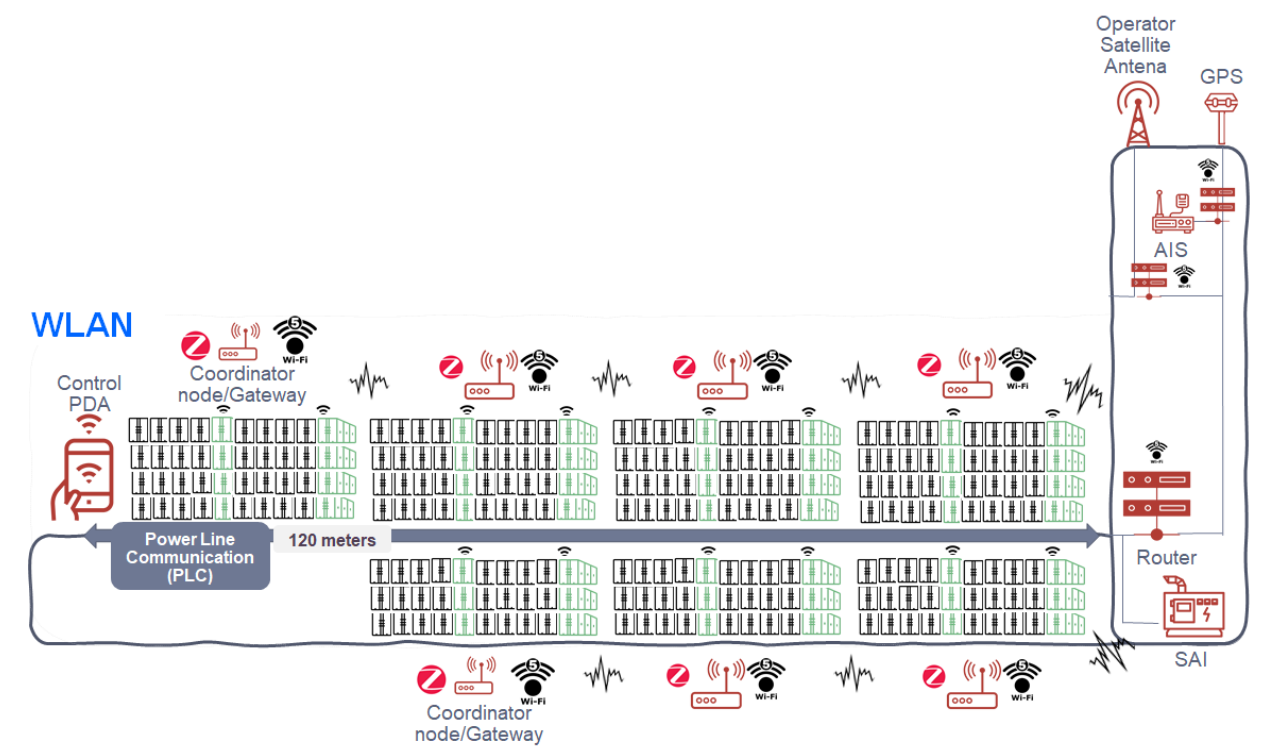
Figure 4. WLAN subsystem scheme.